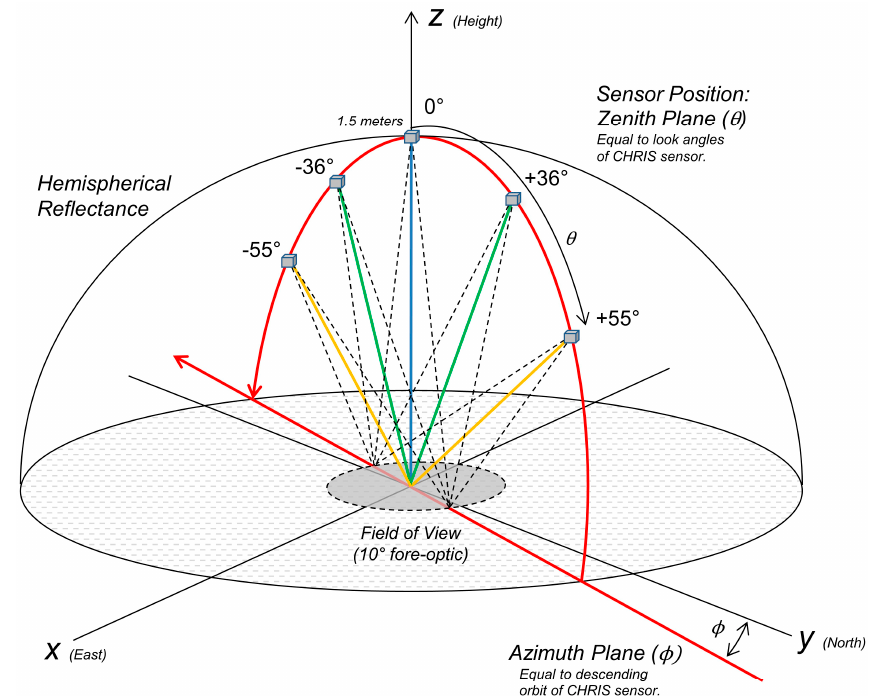
Figure 3. Conceptual multi-angular spectral sampling technique modelled after the descending path of the CHRIS/PROBA satellite over the targets. Spectral measurements were collected at five angles (+55°, +36°, 0°, − 36°, and − 55°) at a descending orbital pathway of ~7.84° (relative to north). Elliptical off-nadir GFOV not shown for graphical clarity.